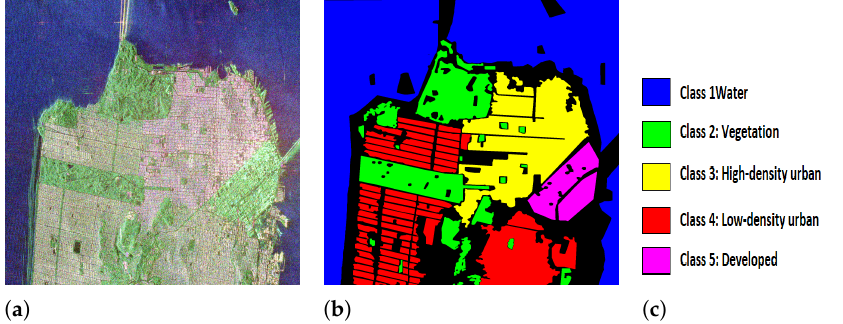
Figure 5. The San Francisco dataset. ( a ) Pauli RGB image; ( b ) ground truth; ( c ) color code of the different